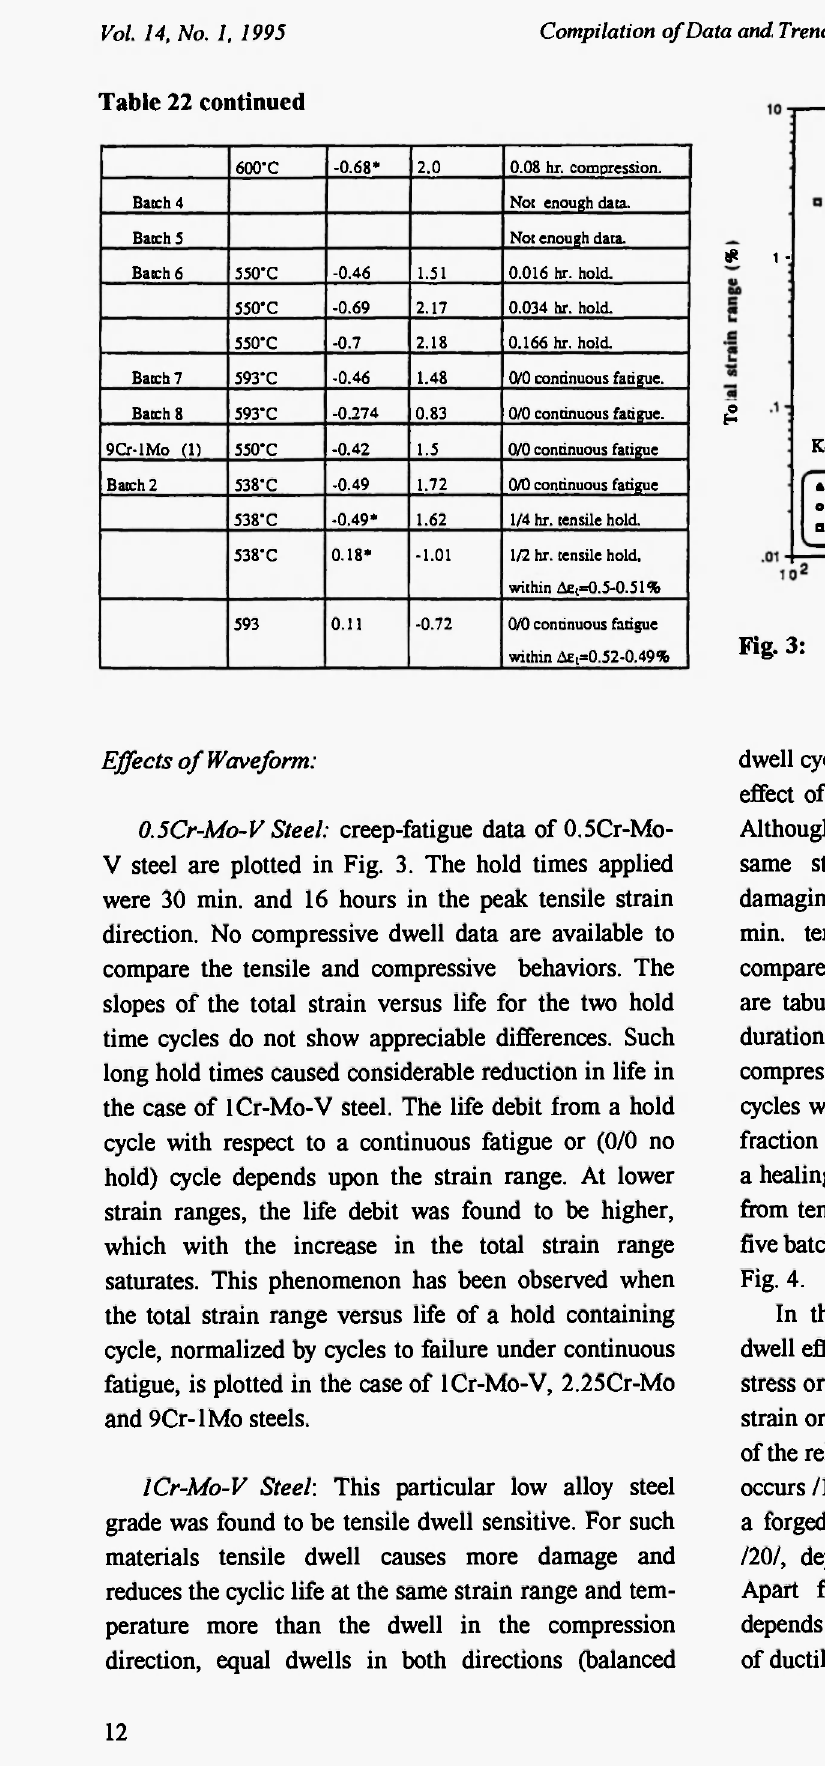
Fig. 3: Creep-fatigue behavior of 0.5Cr-Mo steel with different hold times.